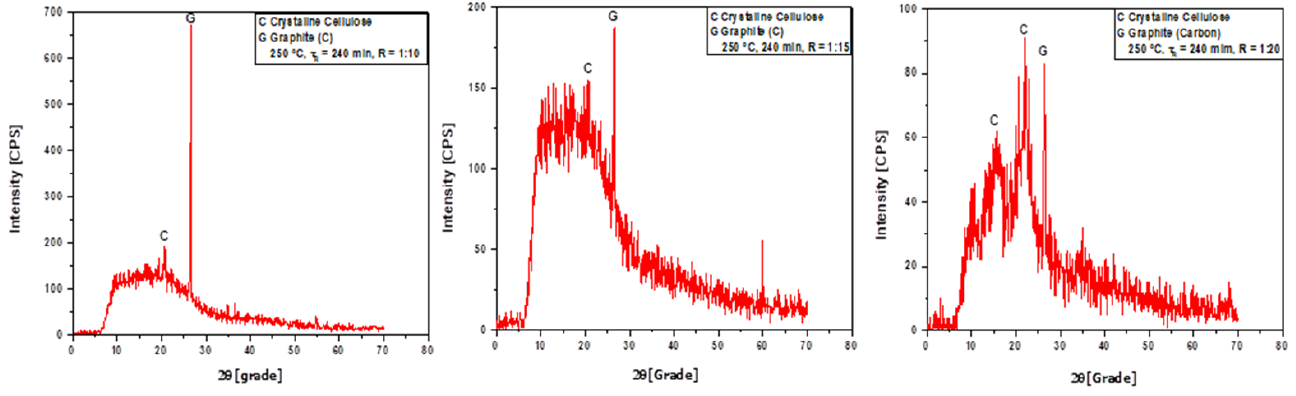
Figure 12. XRD of hydro-chars obtained by the hydrothermal processing of corn stover at 250 °C after 240 min with biomass/H 2 O ratios of 1:10, 1:15 and 1:20 using a reactor of 18.75 L.